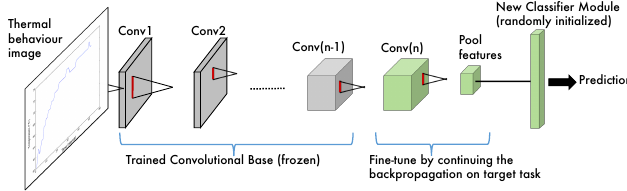
Figure 4. Network architecture used for